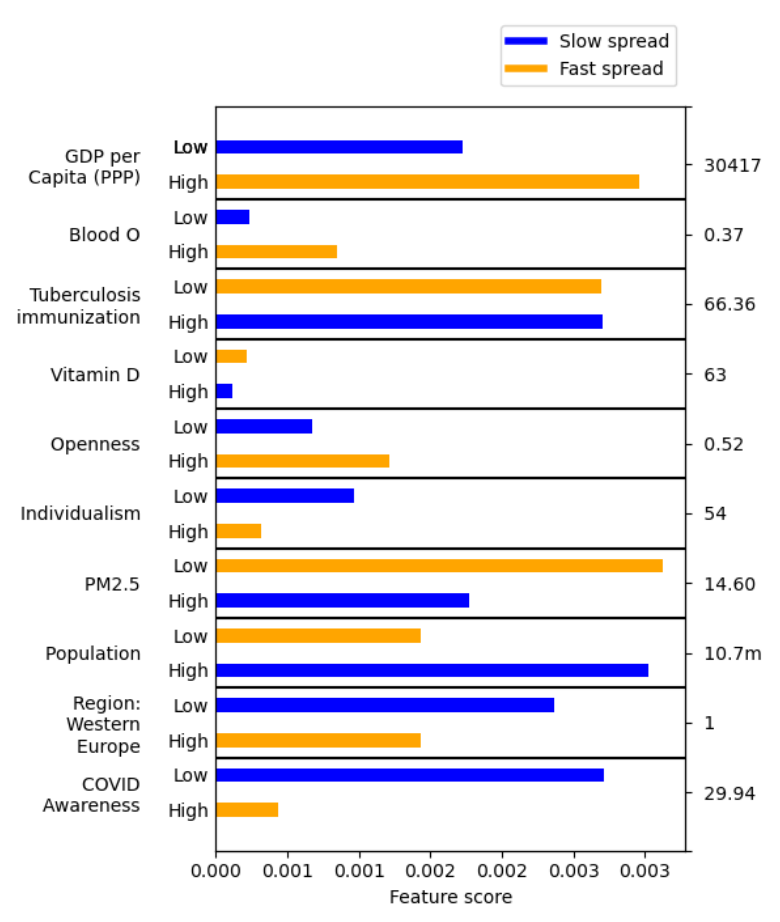
Figure 6. The contributions of feature values discretized into low and high to the slow and fast infection spread for features selected using the Wrapper procedure for the Avg. daily infections class. The right side of the graph shows the number dividing the feature values into low and high.